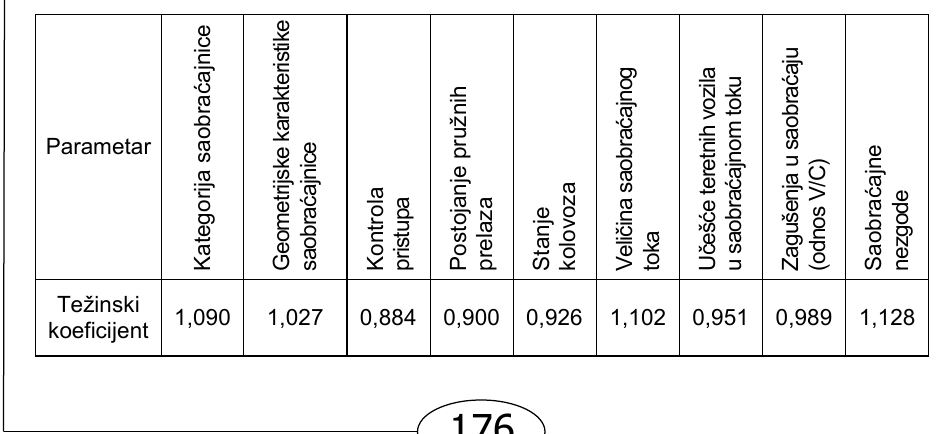
Table 1 – The parameters that affect the probability of occurrence of incidents and their